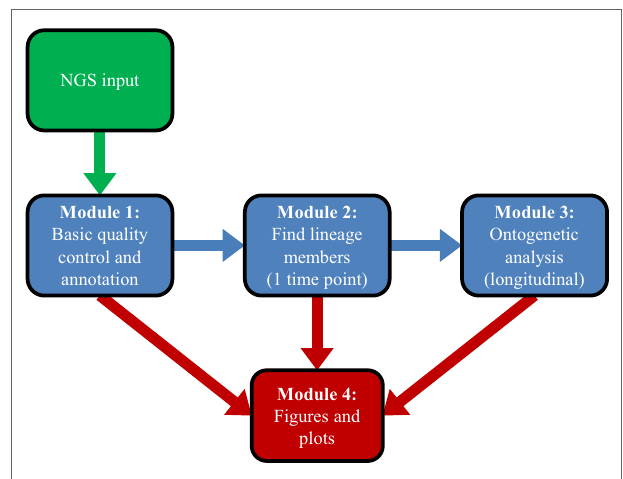
FIgURe 1 | overview of soNAR workflow . Green represents input data, blue indicates analysis steps, and red denotes graphical